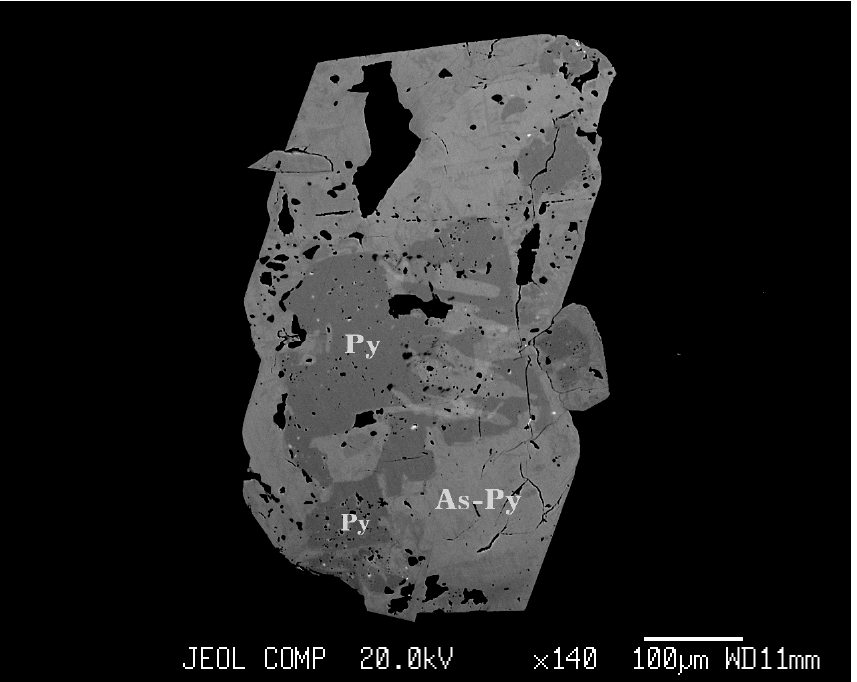
Figure 3. The scanning image in back scattered electrons (BSEs) of pyrite crystal with coexisting “pure” (As-free) and As–pyrite (sample ZR-10/13). Note that more dark areas corresponding to “pure” pyrite display elevated porosity.